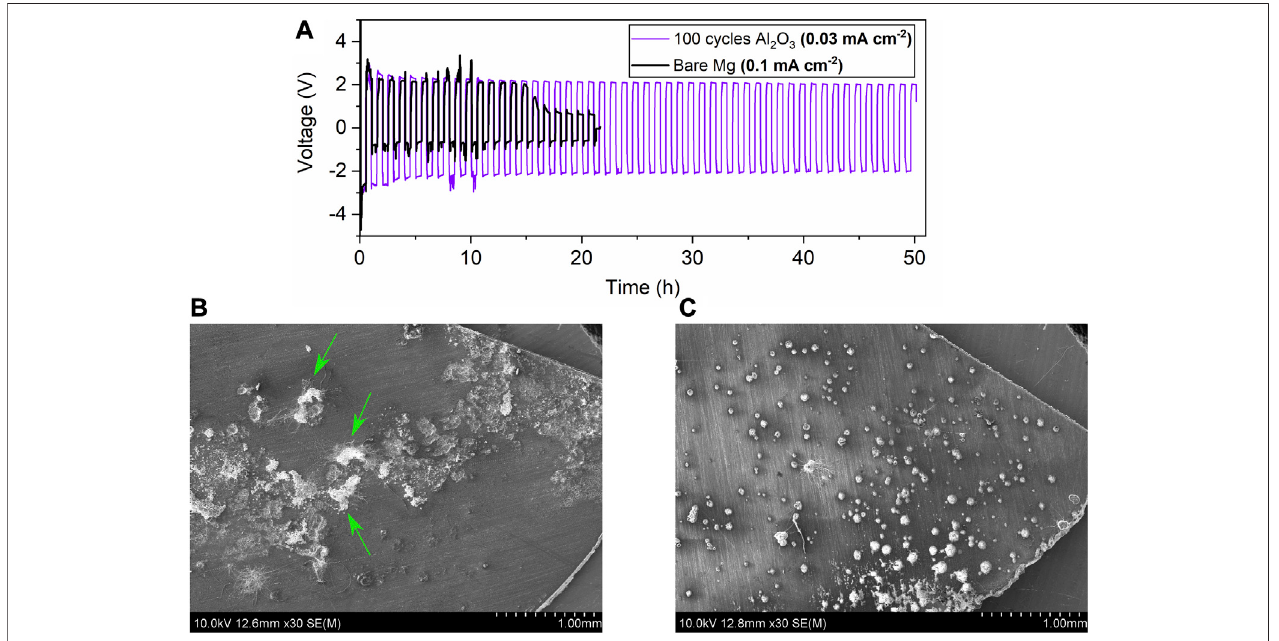
FIGURE 5 | Galvanostatic and SEM data for both bare Mg and 10 nm Al 2 O 3 on Mg (A) Galvanostatic cycling for both samples (B) SEM of bare Mg after 20 cycles with arrows pointing to pieces of the separator, and (C) SEM of 100 cycle covered sample after 50 cycles. The green arrows indicate pieces of glass fi ber separator attached to the deposits on the Mg foil